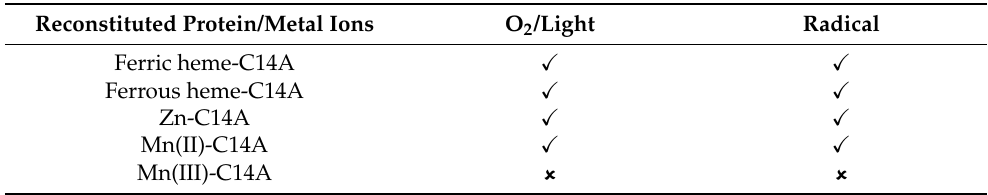
Table 3. Formation of the covalent linkage with different reconstituted proteins under the condi- tions employed in this study. ( ✓ ) The linkage formation is achieved; (  ) the linkage formation could not be achieved.